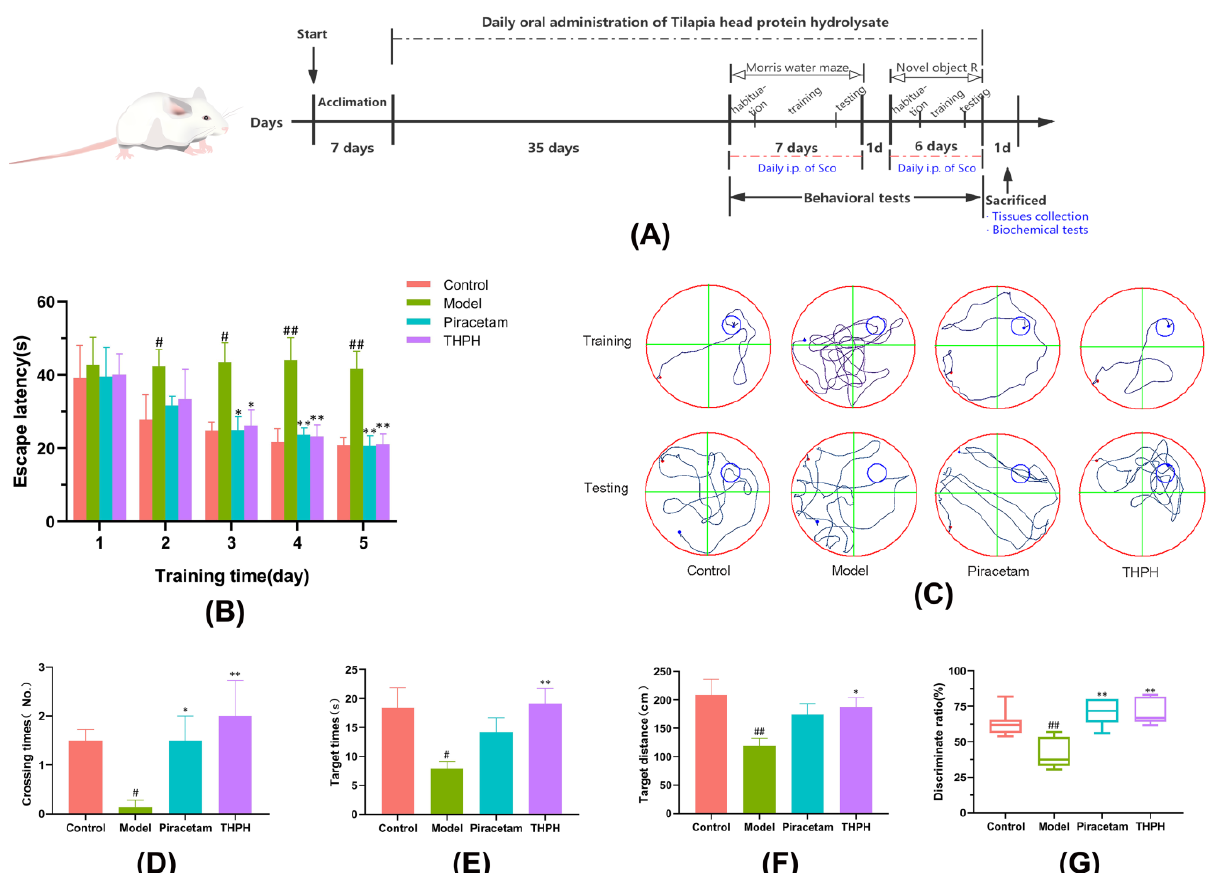
Figure 1. Effect of THPH on the behavioral performance of the Morris water maze test and the novel object recognition test in scopolamine-induced amnesia mice. ( A ) Experimental protocol of animal tests. Sco indicates scopolamine; i.p. indicates intraperitoneal injection. ( B ) Effect of THPH on escape latency of mice in the training trials. ( C ) Representative swimming paths of mice on the fifth day of the training period and the testing day. ( D ) Number of times the mice crossed the platform on the testing day. ( E ) Swimming times of the mice in the target quadrant on the testing day. ( F ) Swimming distance of mice in target quadrant on the testing day. ( G ) Discrimination index of mice in novel object recognition test. Data are presented as means ± SEM. # p < 0.05 and ## p < 0.01 compared to the control group; * p < 0.05 and ** p < 0.01 compared to the model